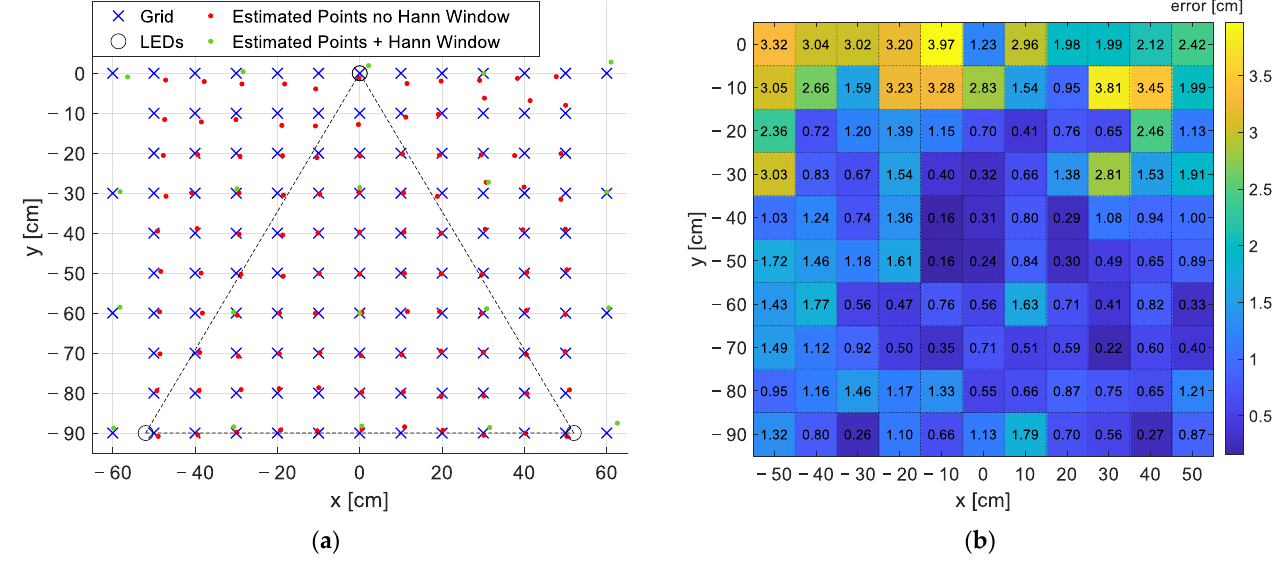
Figure 7. Results of the positioning test in 110 measurement points equally spaced by 10 cm. ( a ) Qualitative grid representation with the origin of the reference system fixed in correspondence of LED 1 : in blue the ‘true positions’ of the grid points, in red the coordinates estimated without windowing operation, in green the points estimated at steps of 30 cm using the Hann window, in black the circles identifying the LEDs positions (top of the grid LED 1 , bottom right LED 2 and bottom left LED 3 ) and the triangular area subtended by the LEDs. ( b ) Numeric representation of the error in each point as a heatmap, the values in the map report the exact error in cm.